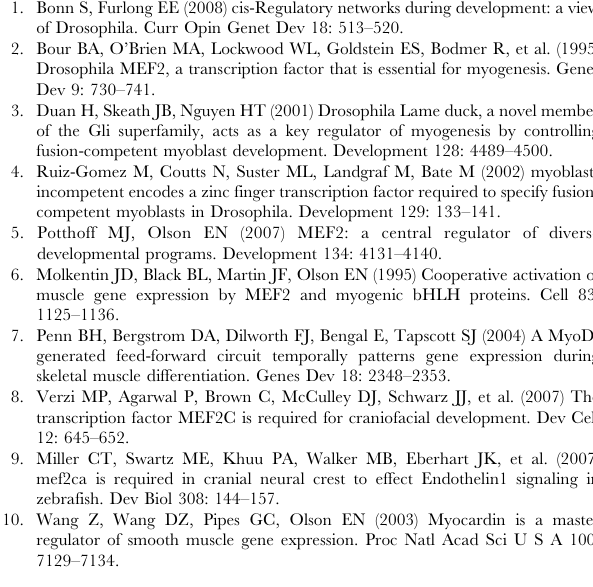
Table S2 Overlap of ChIP data with previously characterised enhancer regions. Table S3 Lmd expression profiling timecourse. Table S4 Direct targets genes of Lmd and Mef2. Table S5 Expression profiling of Lmd direct target genes in Lmd and Mef2 mutant